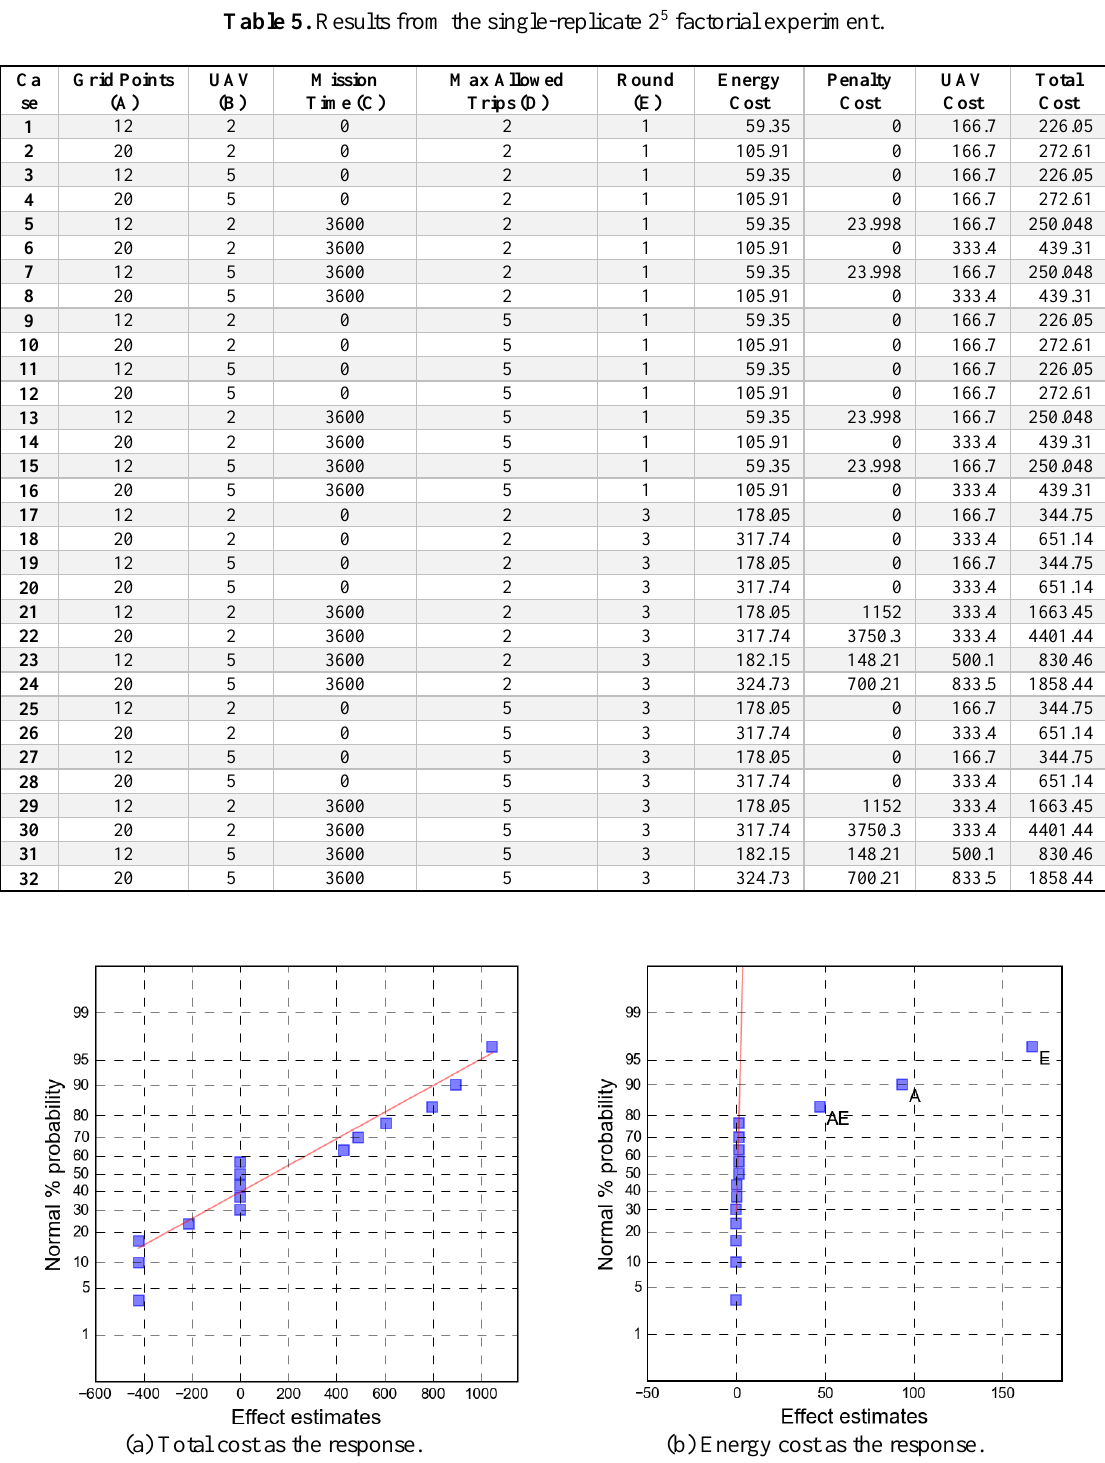
Figure 2. Normal probability plots of effect estimates based on the total cost and the energy